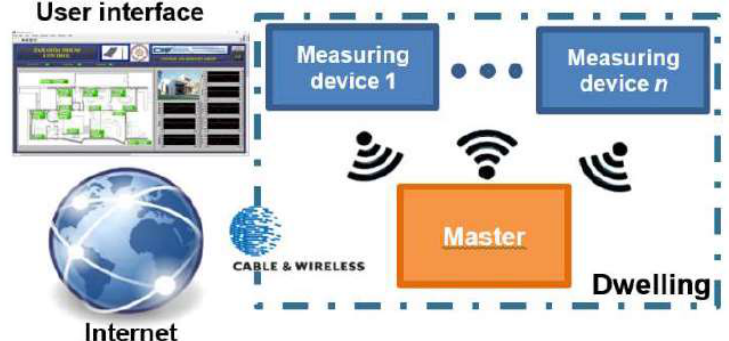
Figure 2. The developed instrumentation/control system.